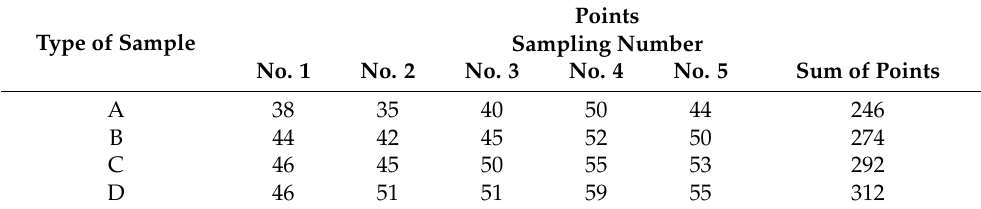
Table 7. Cumulative sum of points obtained from samples during all collections.